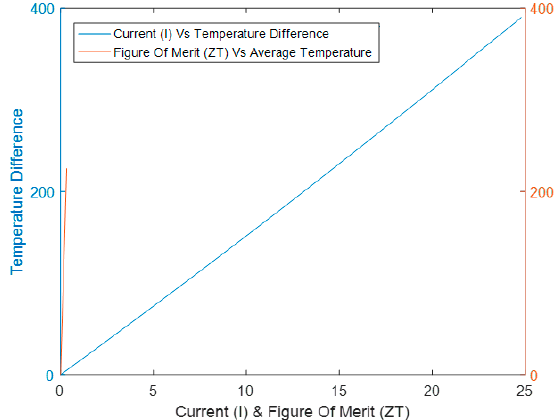
Figure 8. Effect of temperature variance on efficiency, voltage, and power. Energies 2018 , 11 , x FOR PEER REVIEW